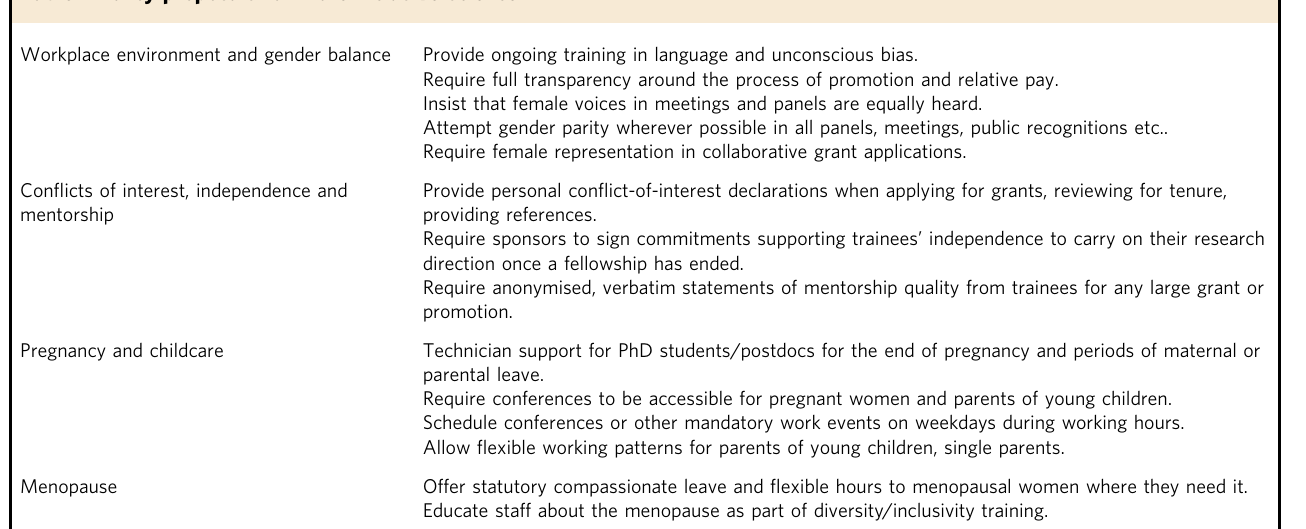
Table 1 Policy proposals for more inclusive